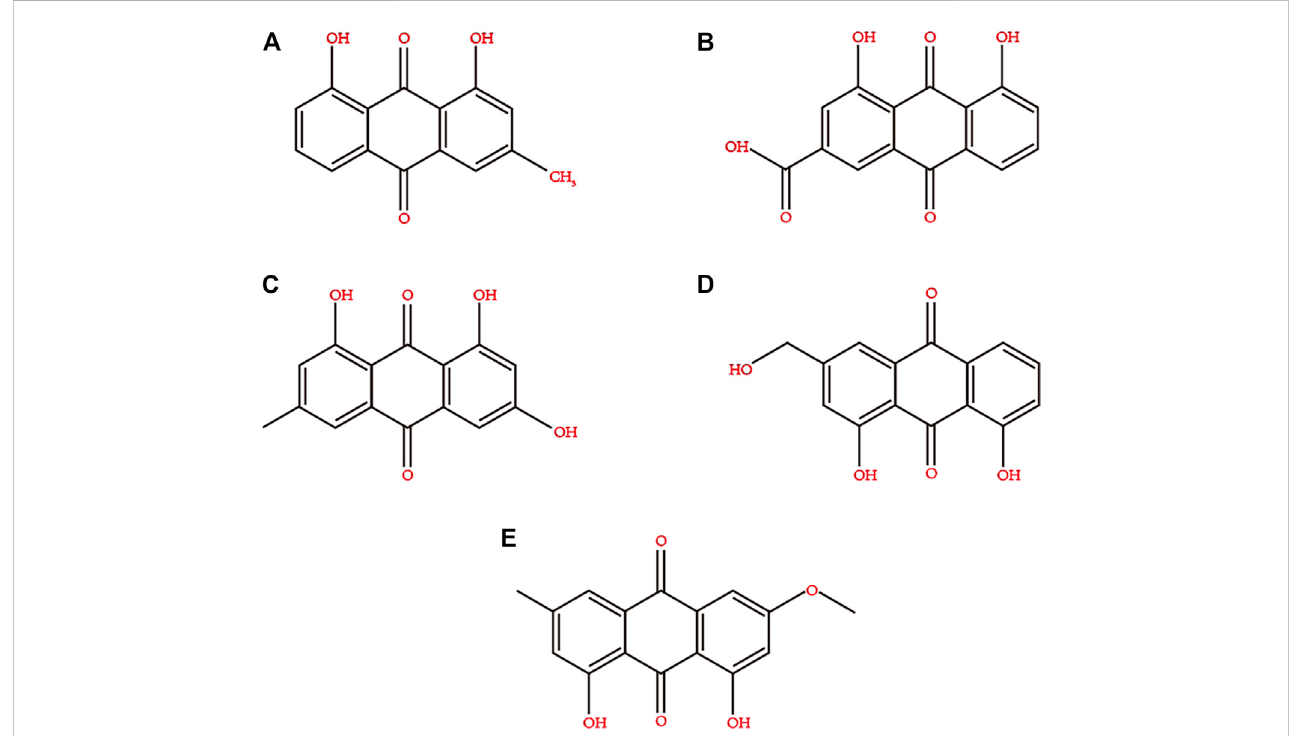
FIGURE 2 Chemical structures of the main active ingredients of Rhubarb. (A) chrysophanol, (B) rhein, (C) emodin, (D) aloe-emodin, (E) emodin methyl ether.